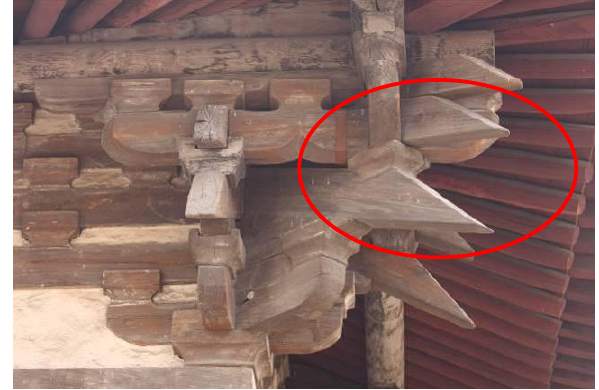
Figure 8 “pi zhu ang” with a straight slope